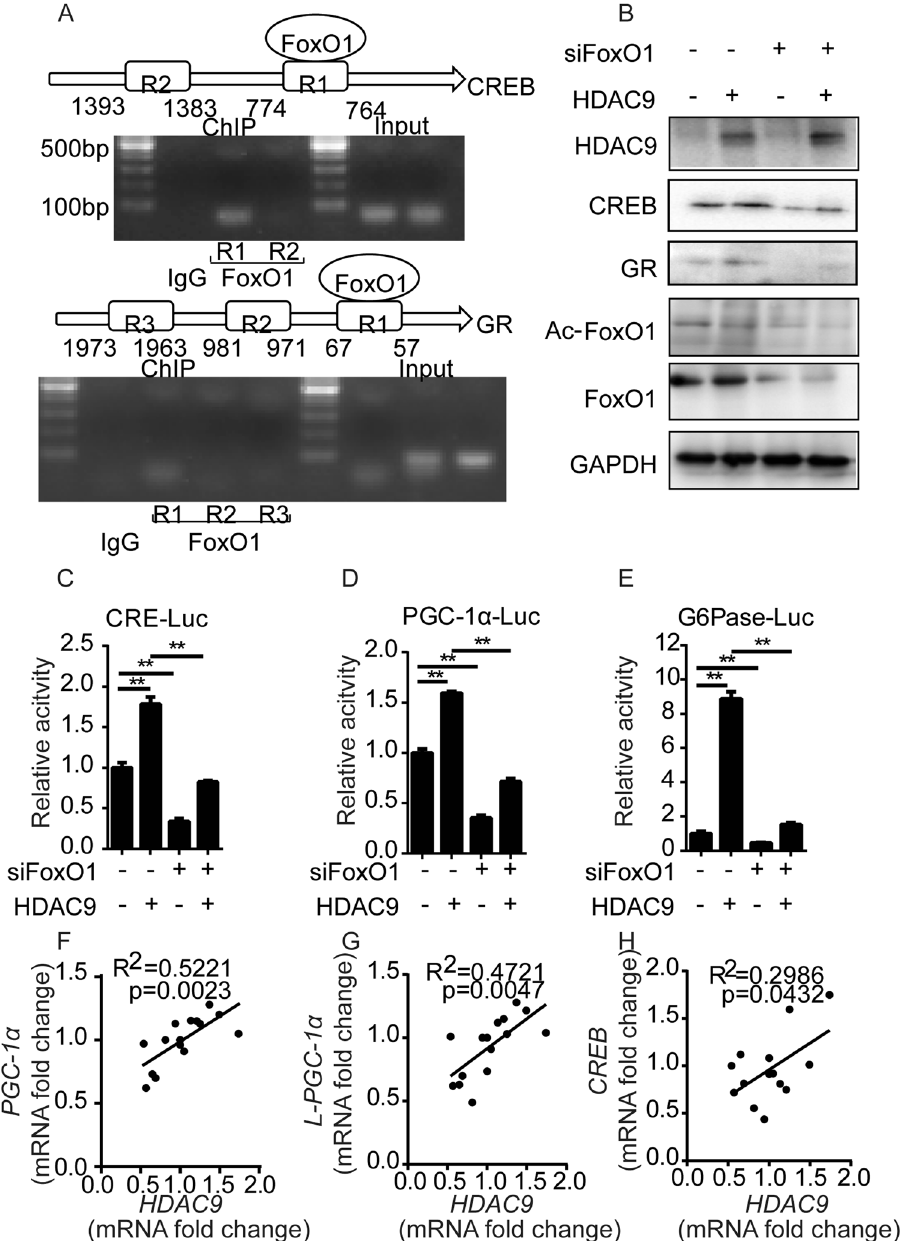
Figure 5. HDAC9-FoxO1 signalling is required for the regulation of gluconeogenic transcription factors. ( A ) In vivo binding of FoxO1 to chromatin sites in CREB and GR. The positions of FoxO1 binding sites are indicated within the CREB and GR proximal promoter regions. Chromatin immunoprecipitation assays with an antibody to FoxO1 were used to detect FoxO1 bound to the proximal CREB or GR promoter in HuH7 cells. Rabbit IgG was used as a negative control. ( B ) The indicated proteins were analysed following HDAC9 overexpression, FoxO1 knockdown, or a combination of the two. ( C – E ) CRE-Luc ( C ), PGC-1 α promoter ( D ), and G6Pase promoter ( E ) activities as in ( B ). ( F – H ) A positive correlation between HDAC9 mRNA levels and PGC-1 α ( F ), L-PGC-1 α ( G ), or CREB ( H ) mRNA level was observed in normal individuals. Data are represented as the mean ± SEM for triplicate